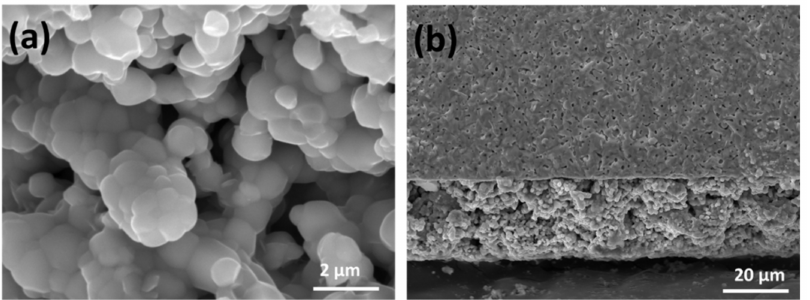
Figure 2. Back-scattered electron (BSE) images of ( a ) LCFCr electrode layer and ( b ) the cross-section of a LCFCr/GDC interface of an as-prepared